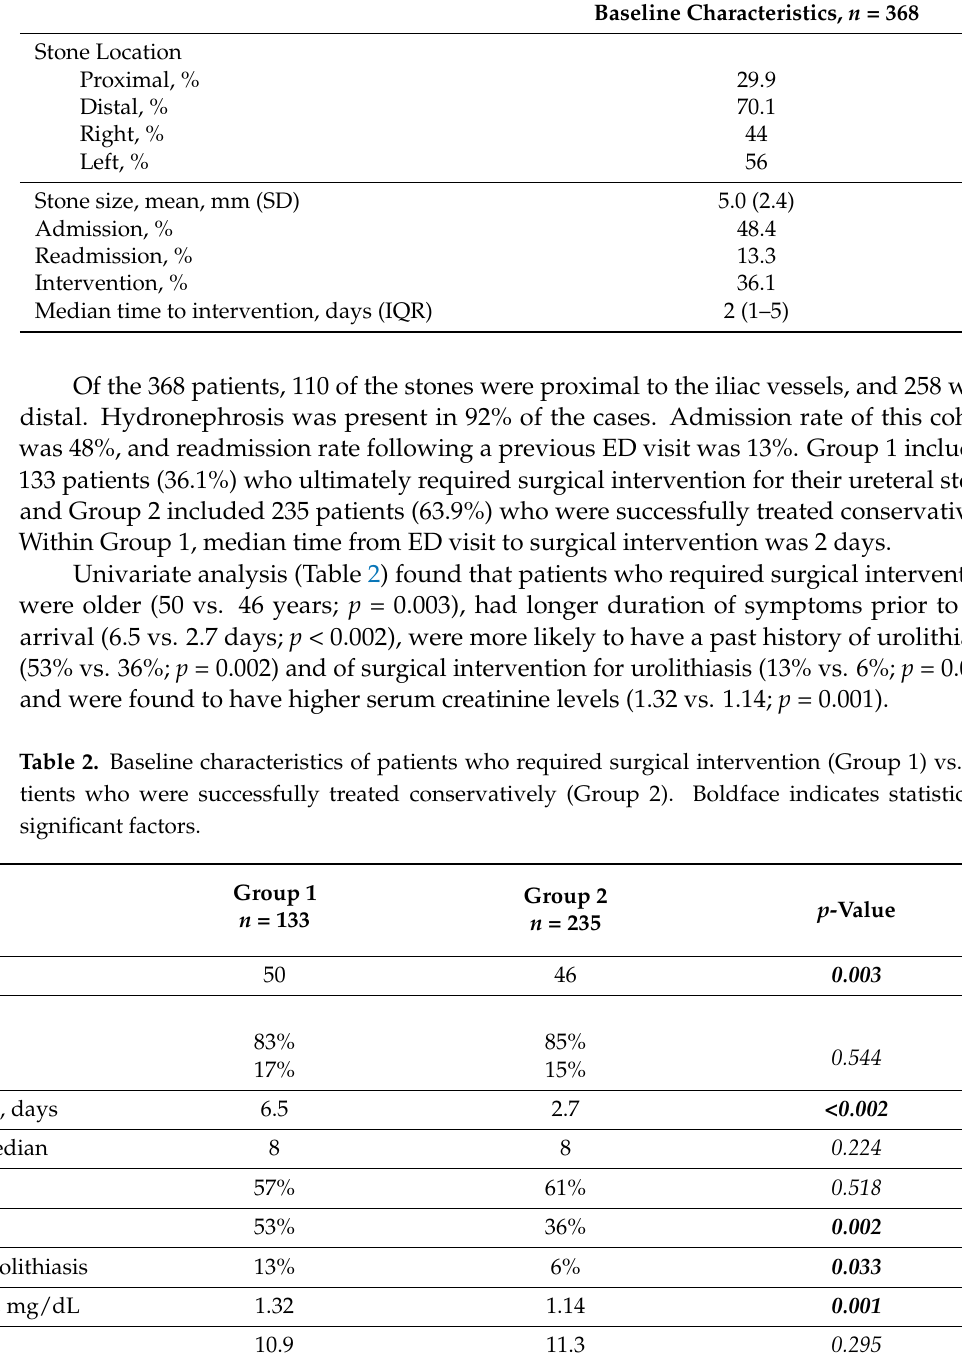
Using ROC curves (Figure 1), cut-off levels were defined for serum creatinine (1.5 mg/dL), duration of symptoms (1.5 days) and age (45 years). Using these cut-off levels, multivariate analysis (Table 3) further narrowed the statistically significant risk factors, identifying three key criteria as predictors for surgical intervention: serum creatinine level > 1.5 mg/dL (OR 2.8, 95% confidence interval (CI) [1.5–5.6]), duration of symptoms prior to ED arrival > 1.5 days (Odds Ratio, OR 2.3; 95% CI [1.4–3.8]) and age > 45 years (OR 1.7; 95% CI [1.02–2.7])). All three of these predictors of surgical intervention were correlated significantly to stone location and size, both individually and combined (Table